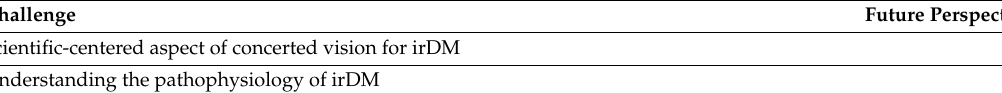
Table 5. Main challenges and future perspectives regarding